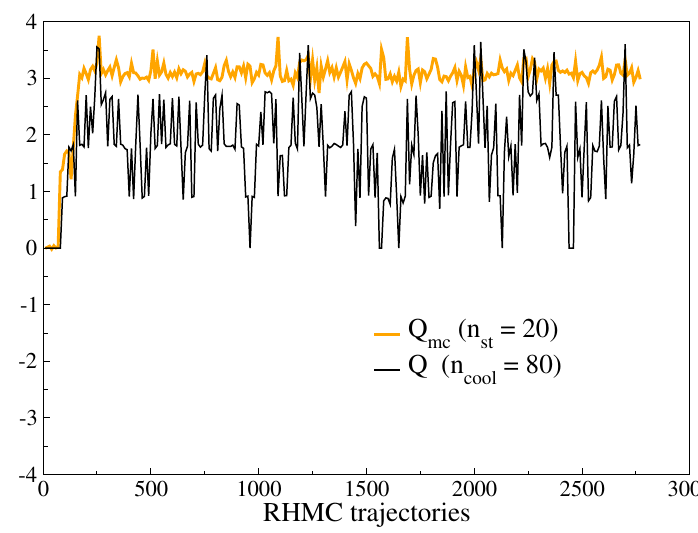
Figure 4 . Monte-Carlo history of the topological charges obtained after 80 cooling steps and after 20 stout-smearing steps (with (cid:26) st = 0 : 1), for the run on the 32 3 (cid:2) 8 lattice at (cid:12) = 4 : 14,